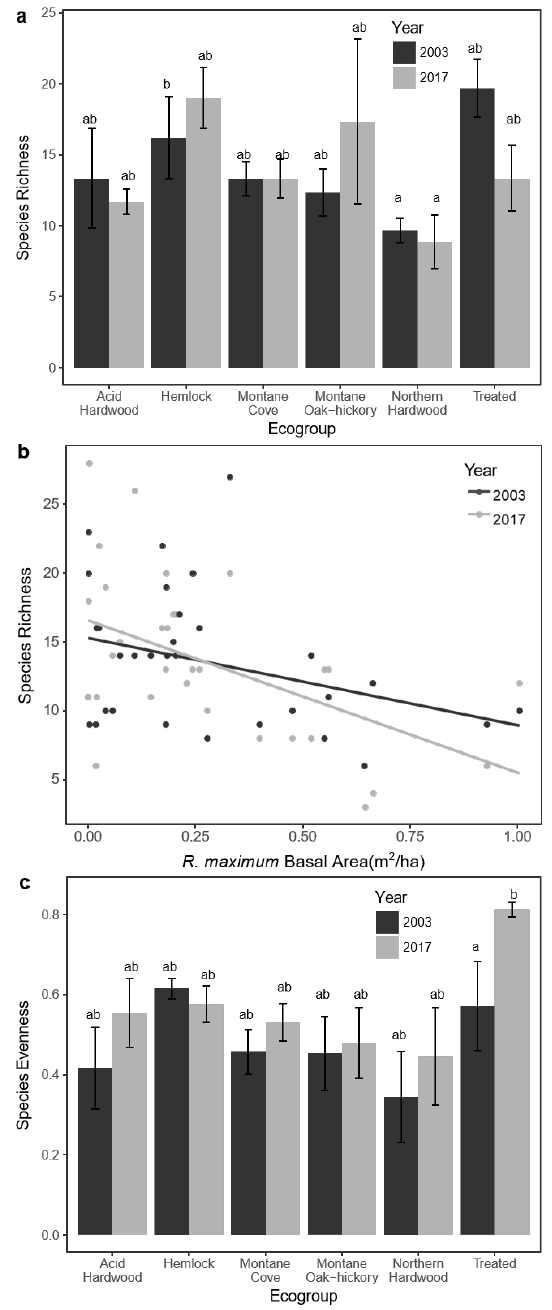
Figure 6. ( a ) Mean (±SE) sapling species richness across ecogroups. Superscripts indicate significant differences between year and ecogroups (α = 0.05); ( b ) Sapling species richness as a function of R. maximum BA; ( c ) Mean (±SE) sapling species evenness across ecogroups. Superscripts indicate significant differences between year and ecogroups (α = 0.05).